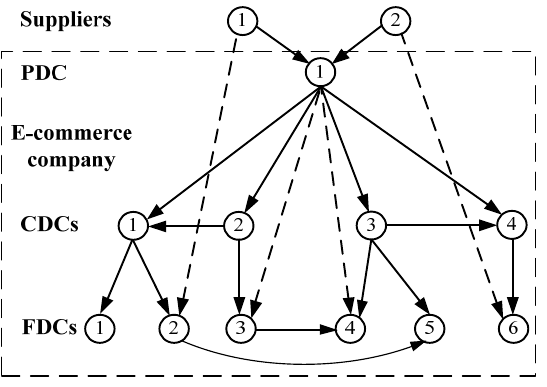
Figure 3. A multiple-echelon distribution system with producers’ distribution center (PDC) in Alibaba.